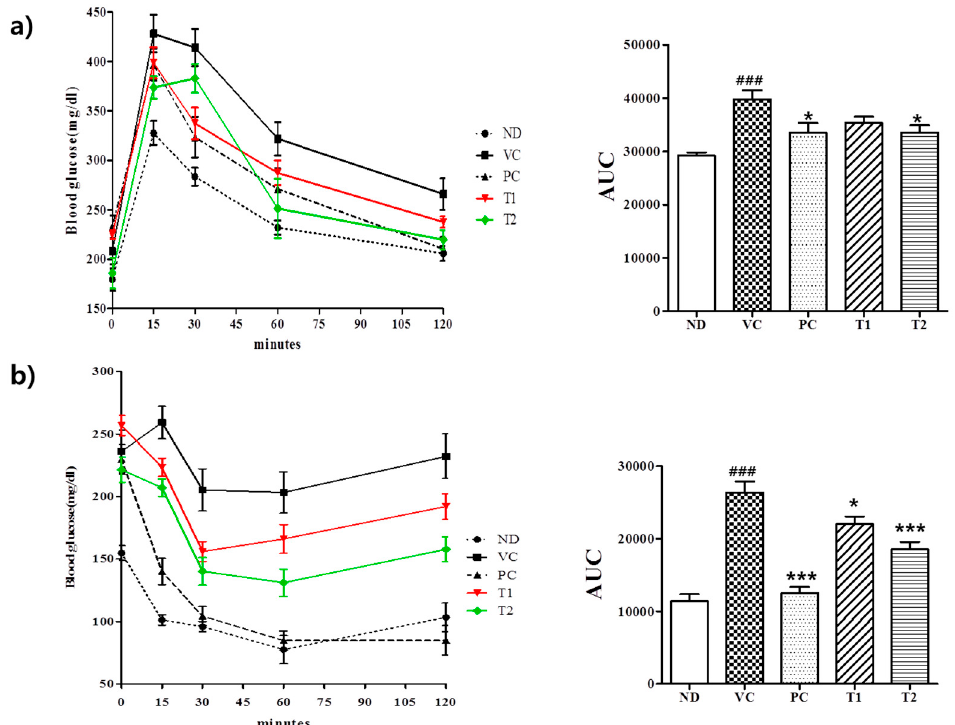
Figure 6. Effect of A. melanocarpa extract on oral glucose tolerance test (OGTT) and the respective AUC ( a ) and intraperitoneal insulin tolerance test (IPITT) and the respective AUC ( b ). Results are presented as means ± SDs ( n = 12); ### p < 0.001 vs. the ND group; * p < 0.05 and *** p < 0.001 vs. the VC group. Group I (ND), normal diet group; Group II (VC), high-fat diet group; Group III (PC), Orlistat-treated group; and Group IV (T1), 100 mg/kg b.w. A. melanocarpa extract-treated group; Group V (T2), 200 mg/kg b.w. A. melanocarpa extract-treated